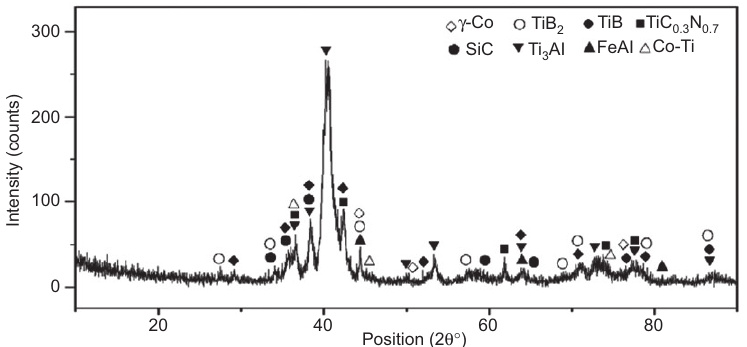
Figure 1 X-ray diffraction diagram of the Co-Fe-Al + B